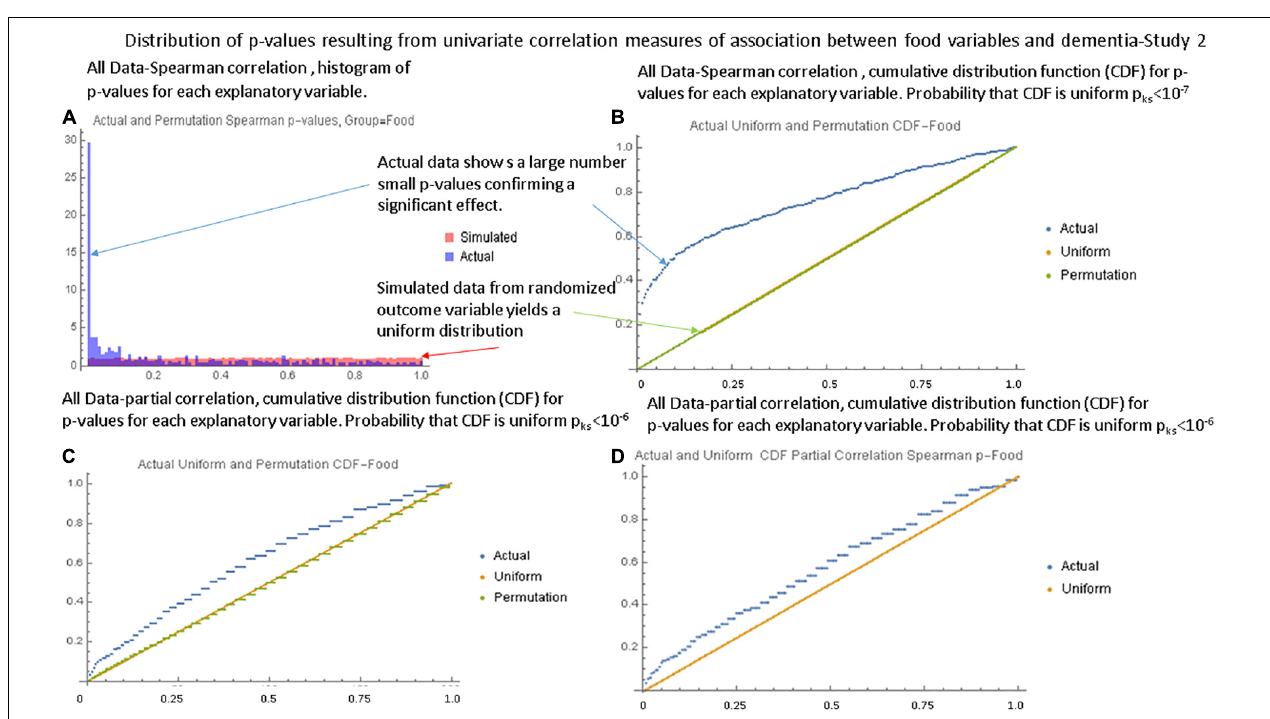
FIGURE 2 | Illustration of the global tests for the second study. (A) Histogram of Spearman correlation p -values for the food variables with the “full” data set. (B) The CDF of the p -values showing a strongly non-uniform shape. (C) The CDF of Spearman correlation p -values in the second study with the “averaged” data set. (D) The CDF of the partial correlation p -values with the “full” data set. Although the shape is closer to that of a uniform distribution, the Kolmogorov-Smirnov test still shows a large statistical difference.